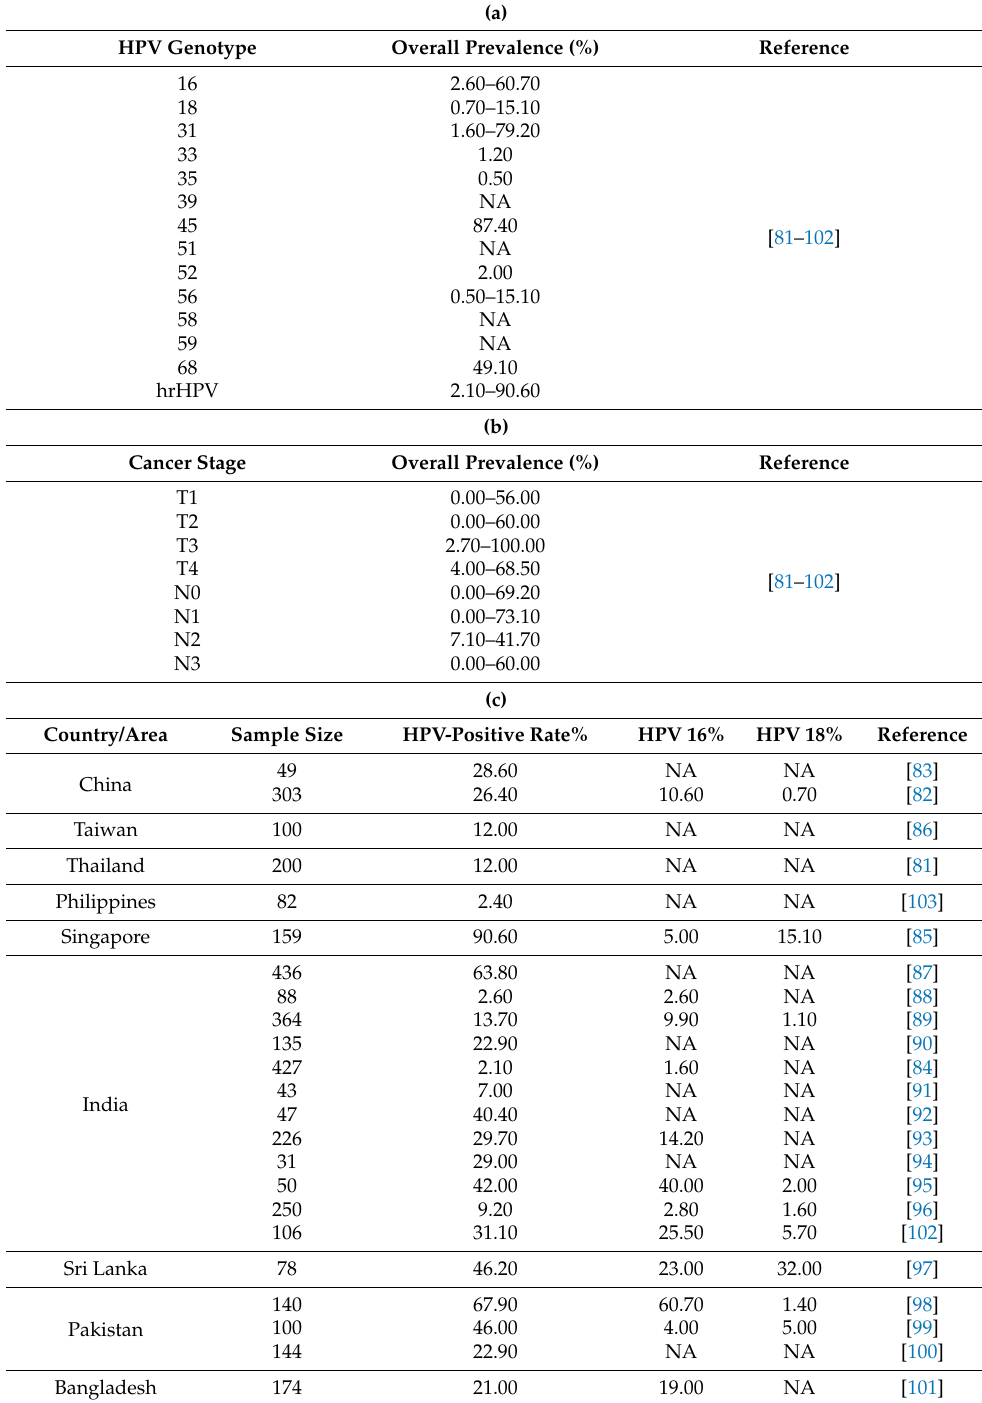
Table 2. Distribution of HPV genotypes in head and neck squamous cell carcinoma (HNSCC) in East, Southeast, and South Asia. ( a ) Prevalence of different HPV genotypes detected in HNSCC. ( b ) HPV prevalence detected in different cancer stages of HNSCC. ( c ) The prevalence of HPV16 and 18 in HNSCC patients by